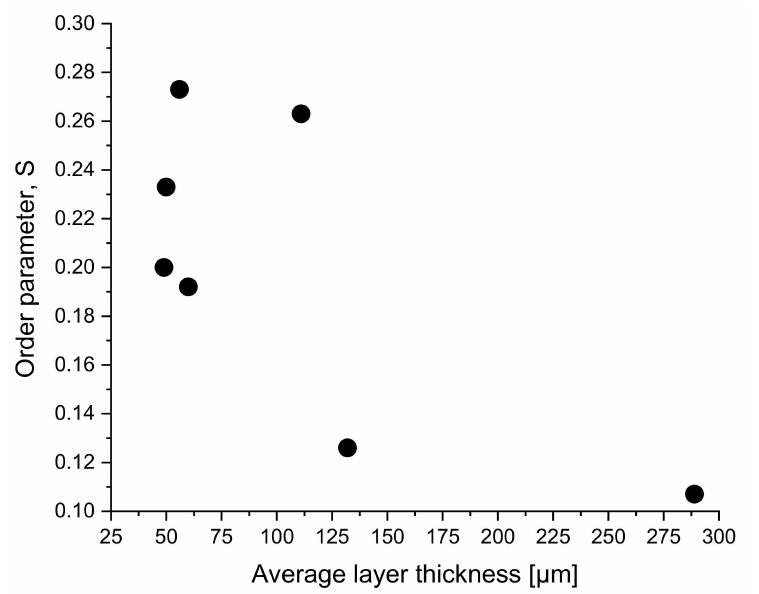
Figure 2. Derived order parameter, S , as a function of the thickness of the deposited layer for 0.05 wt% K160 deposited on PMMA.